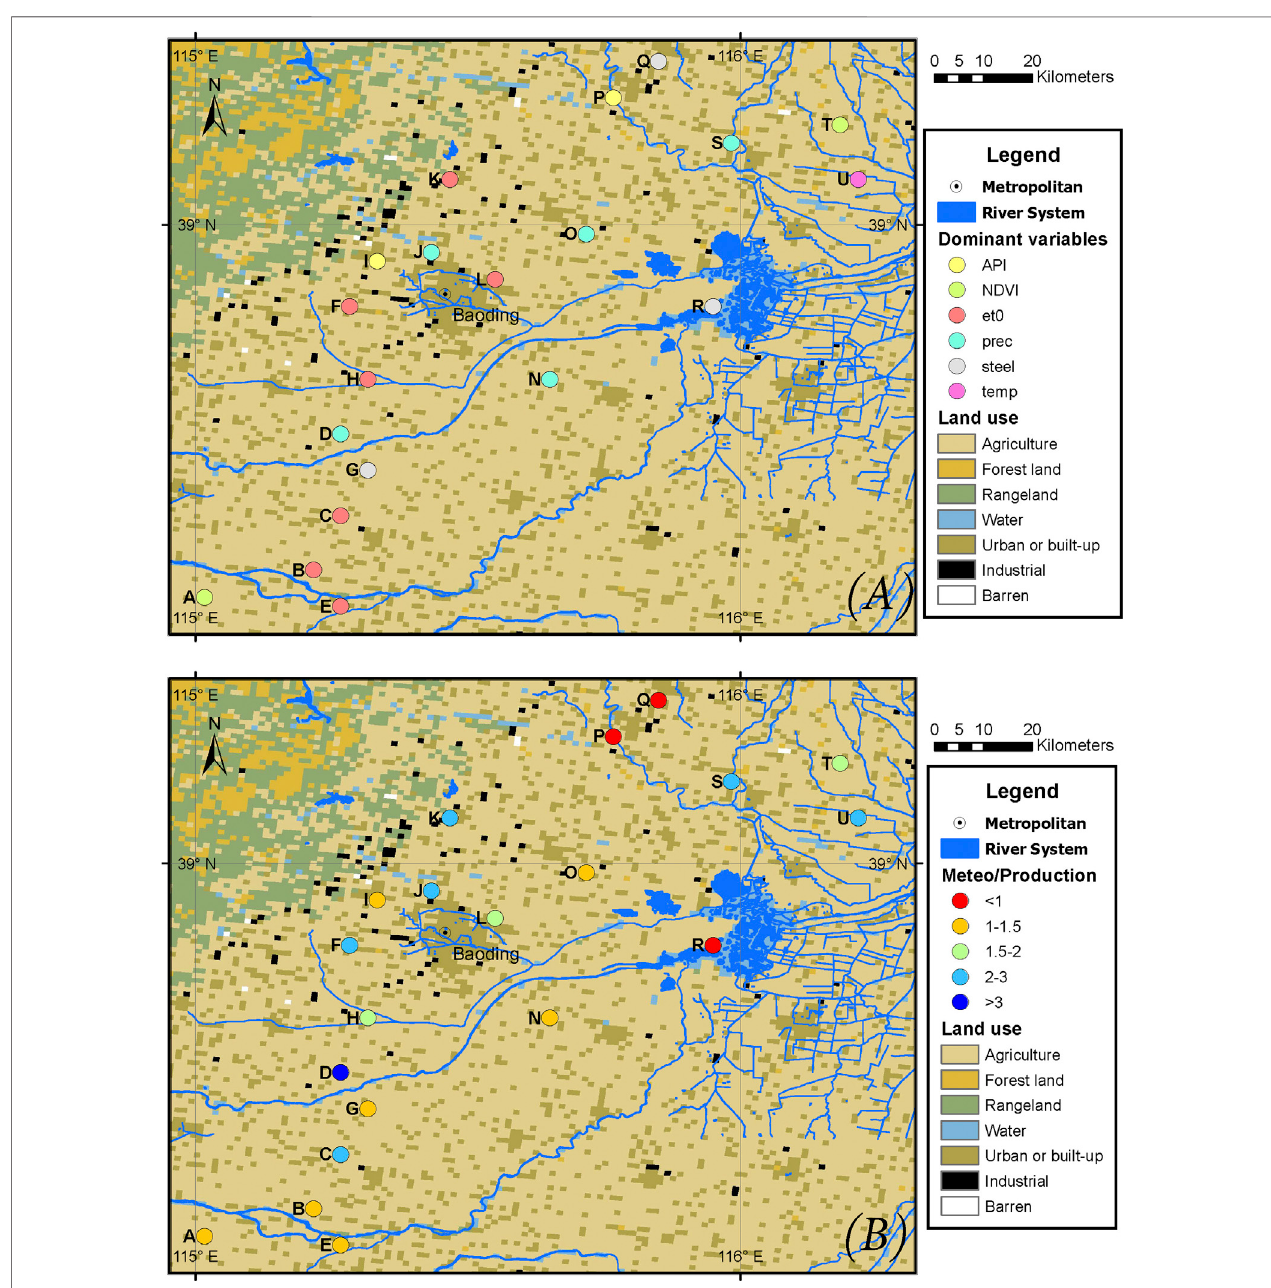
FIGURE 14 | The relationship between land use and importance of variables: (A) Dominant variables at each site (B) The ratio of meteorological factors to production activity factors.